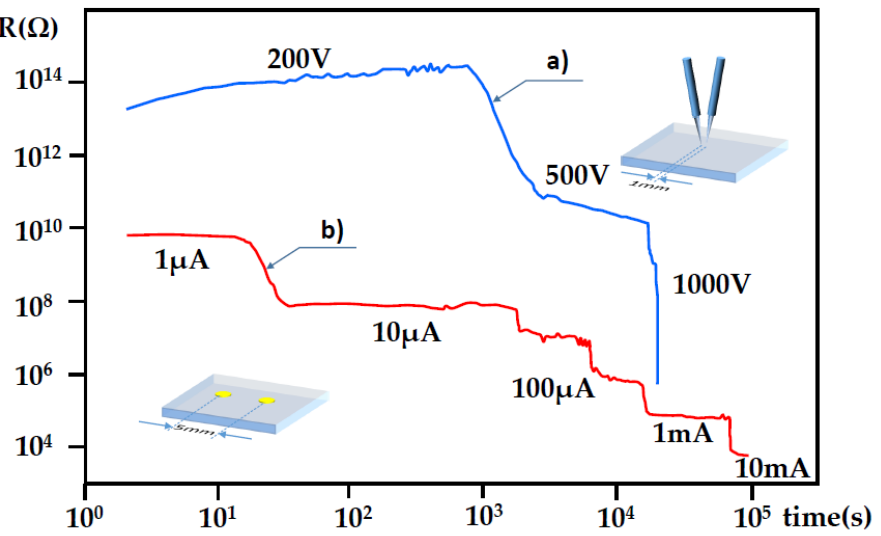
Figure 52. The resistivity of a TiO 2 single crystal during electrodegradation experiment. The ( a ) curve presents a voltage-controlled course with the setup presented in the right inset (two platinum needles were in mechanical contact with the crystal surface). The ( b ) curve presents the current-controlled course obtained with the setup from the left inset (the current was applied to the two platinum electrodes applied on the TiO 2 surface by sputtering). Adapted from [53].